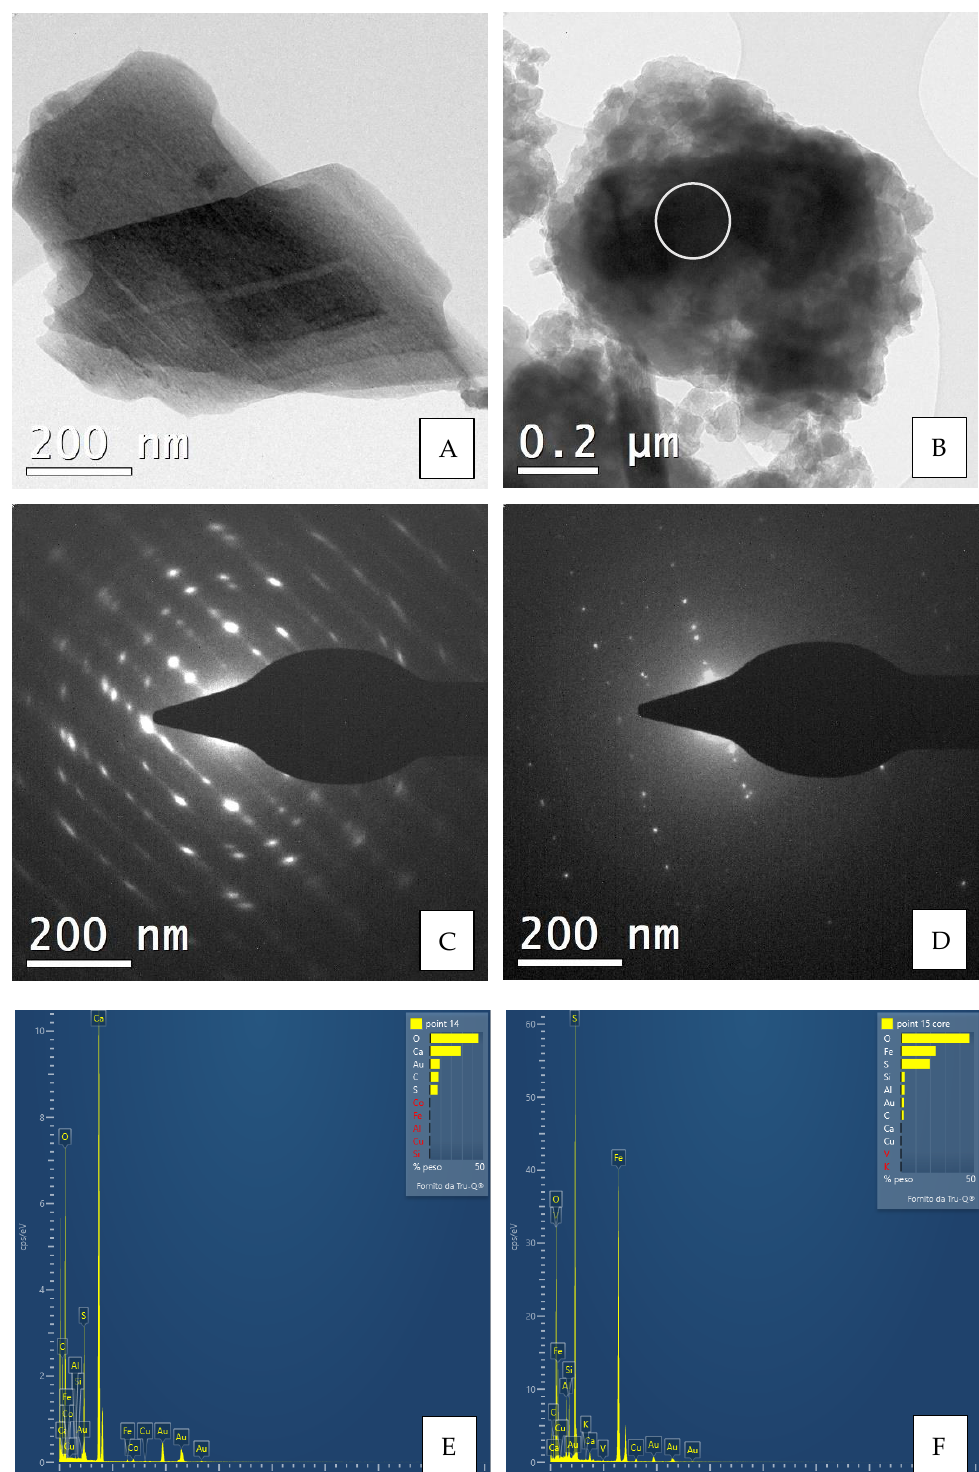
Figure 7. Precipitated phases from FA3-S sample, analyzed by TEM. A nano-crystals aggregate ( A ) probably an Al-Fe-(hydro)silicate phase, as suggested by EDS analysis ( B ). The single-crystal pat- tern ( C ) shows an evident crystalline structure before the interaction with electron beam of the EDS analysis. After EDS beam there is no pattern ( D ), because the structure has been dissolved. The black figure in the center of the images ( C ) and ( D ), whose size remains unchanged as the magnification changes, is the beam stopper.